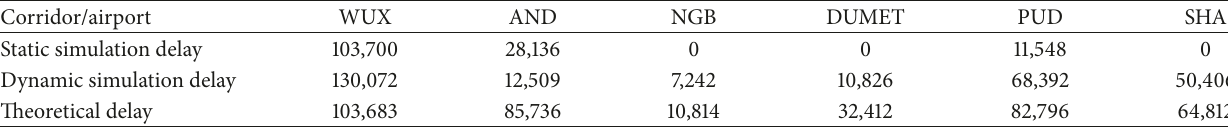
Table 14: Comparative analysis of the delays in the corridor/airport (unit: